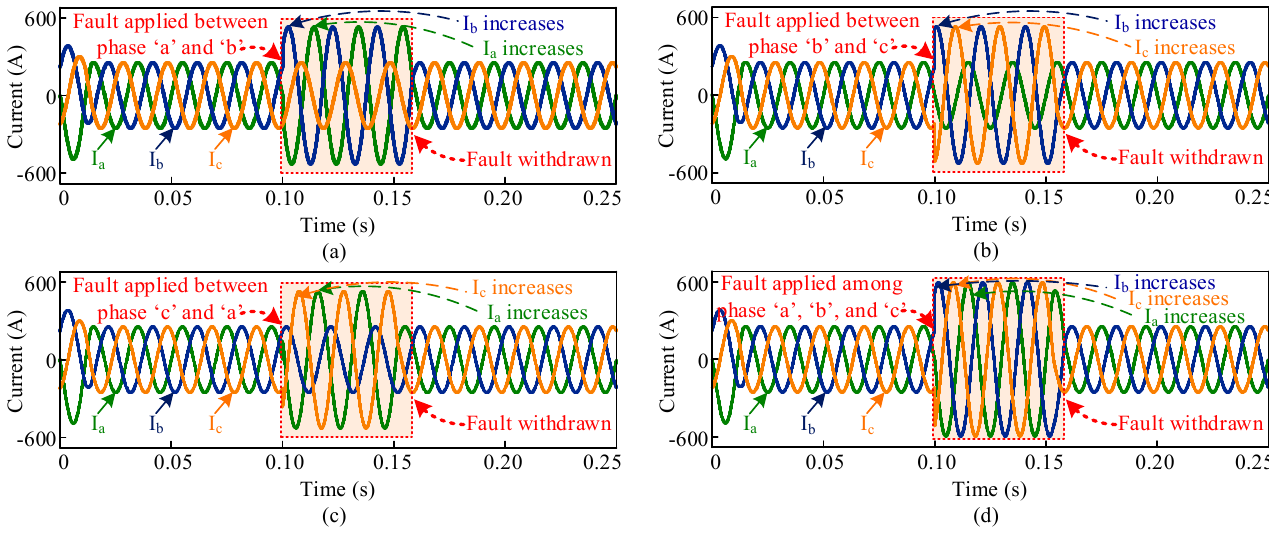
Figure 16. Fault response in inverter current: ( a ) fault is applied in phase “a” and “b” ( b ) fault is applied in phase “b” and “c” ( c ) fault is applied in phase “c” and “a,” and ( d ) fault is applied in phase “a,” “b,” and “c.”